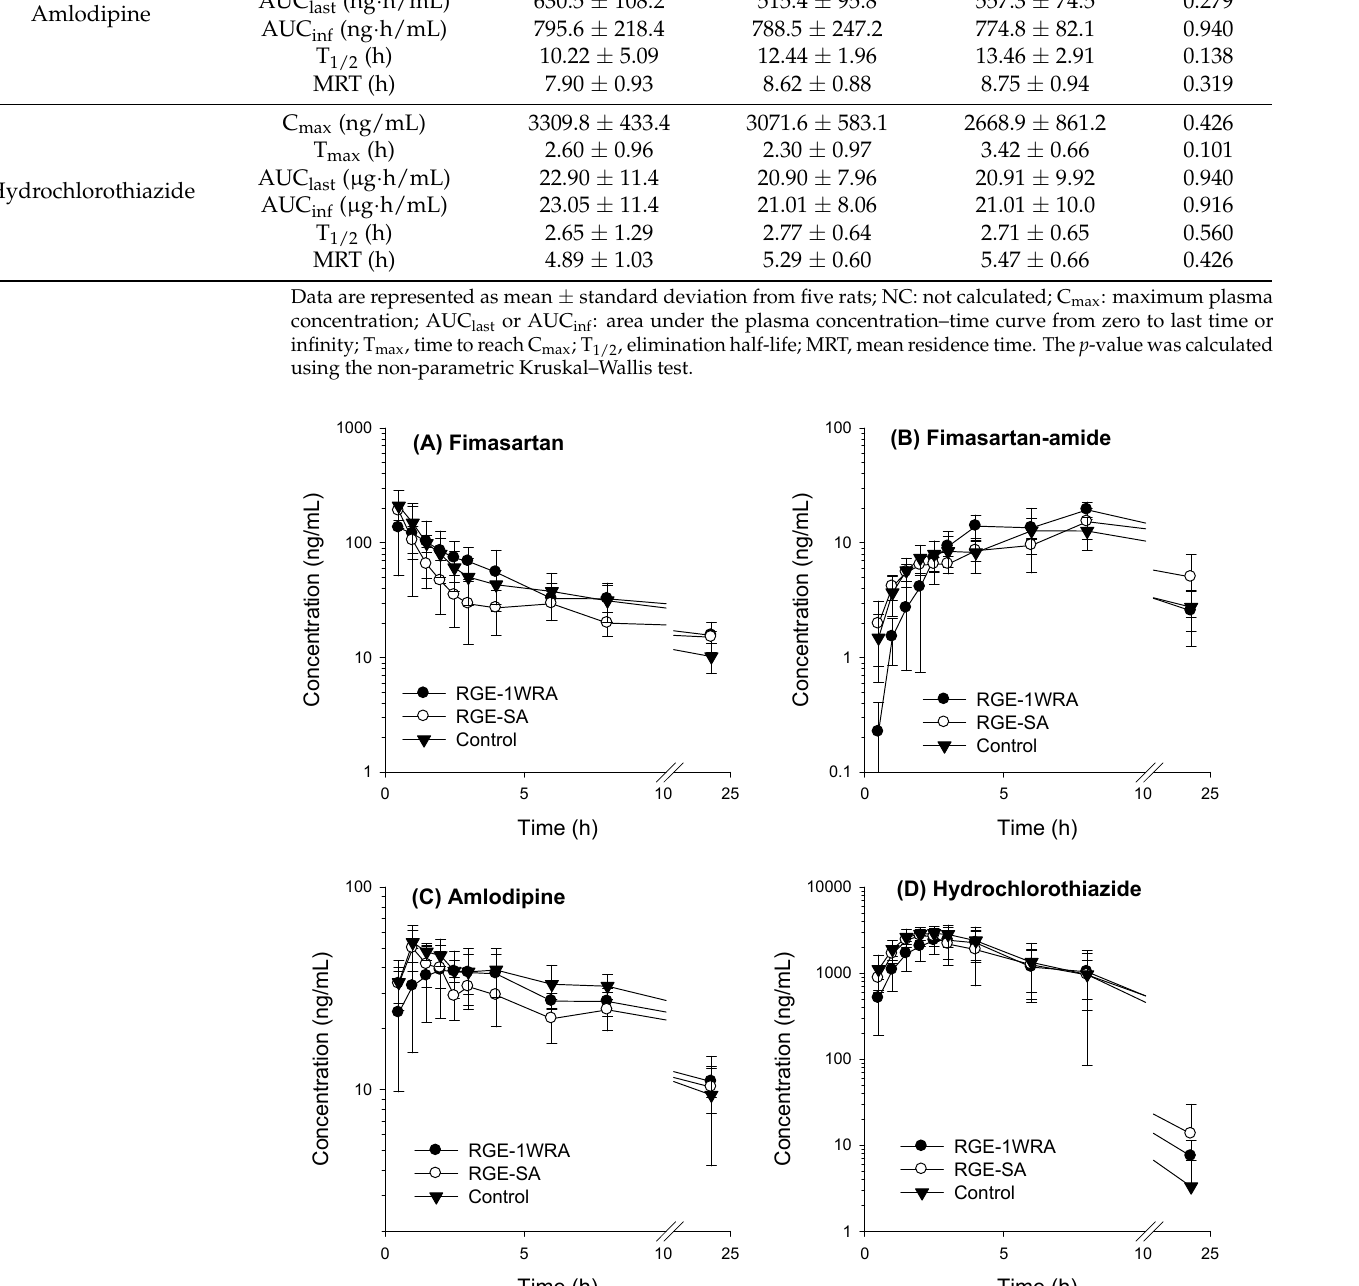
Figure 4. Plasma concentration–time profile of ( A ) fimasartan, ( B ) fimasartan-amide, ( C ) amlodipine, and ( D ) hydrochlorothiazide in rats orally administered a mixture of fimasartan (3 mg/kg), amlodi- pine (5 mg/kg), and hydrochlorothiazide (5 mg/kg) with vehicle (control group), single-dose RGE (1.5 g/kg; RGE-SA) and repeated-dose RGE (1.5 g/kg, once daily for one week; RGE-1WRA). Data represent the mean ± standard deviation ( n = 5).